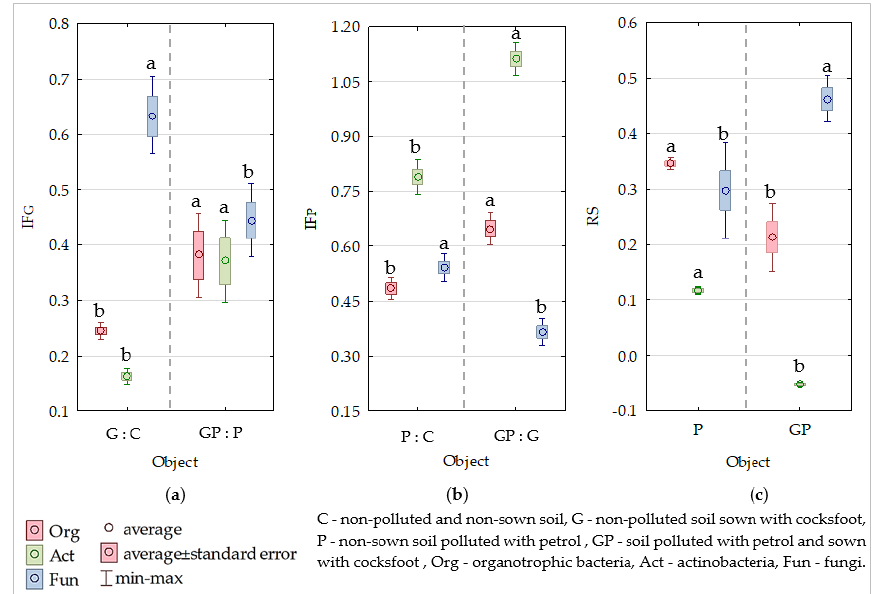
Figure 1. Indices effect: ( a ) of cocksfoot on soil microorganisms (IF G ), ( b ) of petrol on soil microorganisms (IF P ), and ( c ) of resistance (RS) of soil microorganisms to the effects of petrol (P). Homogeneous groups denoted with letters (a,b) were calculated separately for each of the microorganisms. Cocksfoot cultivation in the soil tested contributed to a decrease in the colony development (CD) index of organotrophic bacteria and actinobacteria, and to an increase in the CD index of fungi. The CD index values were similarly affected by soil pollution with petrol. In the non-sown soil, petrol caused an increase in the ecophysiological diversity (EP) index of organotrophic bacteria and fungi, whereas in the soil sown with cocksfoot, it decreased EP index values of all microorganisms tested (Figure 2a,b).